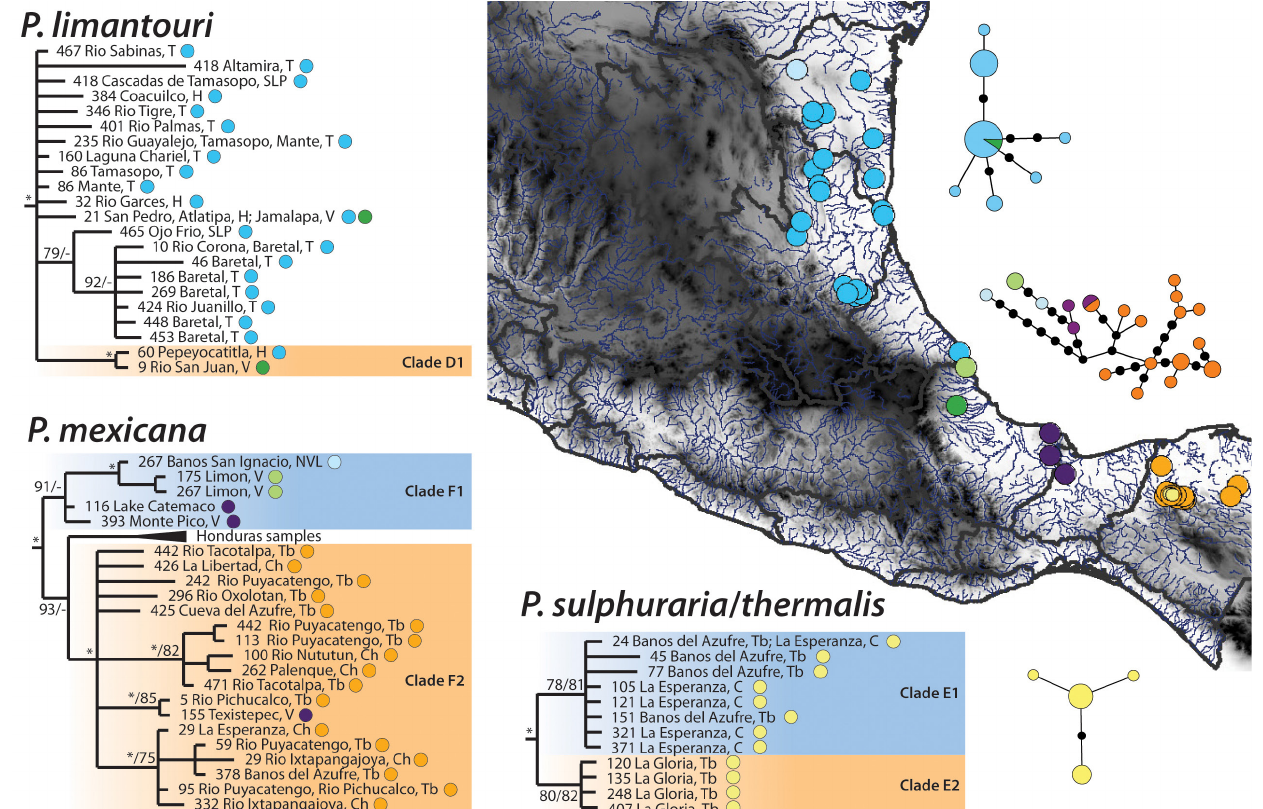
FIGURE 5 | Cytochrome b (1,140 bp) mitochondrial gene Bayesian phylogeny, parsimony haplotype network, and sampling distribution of Atlantic taxa Poecilia limantouri (Turqouise-North of the Trans Mexican Volcanic Belt, forest green-South of the Trans Mexican Belt), P. sulphuraria / P. thermalis (yellow-South of the Isthmus of Tehuantepec), and P. mexicana (baby blue-North of the Trans Mexican Volcanic Belt, light green-South of the Trans Mexican Volcanic Belt, purple-North of the Isthmus of Tehuantepec, orange-South of the Isthmus of Tehuantepec) across geographic barriers along the Atlantic coast of Mexico. The phylogeny has Bayesian posterior values followed by bootstrap values with asterisks representing support of 95% or above. The Parsimony network values correspond to the haplotype values and are colored according by geographic locations separated by barriers; circle sizes correspond to the number of individuals with that haplotype (larger circles reflect more individuals), and black circles indicate unsampled haplotypes. The capital letters at the end of each sample represents the state of origin in Mexico, from North to South: NVL = Nuevo Leon, T = Tamaulipas, V = Veracruz, H = Hidalgo, Tb = Tabasco, C =